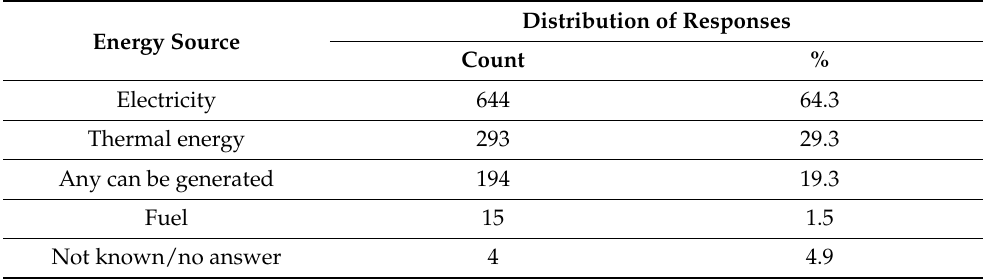
Table 5. Knowledge of energy sources that can be generated by solar collectors ( N =